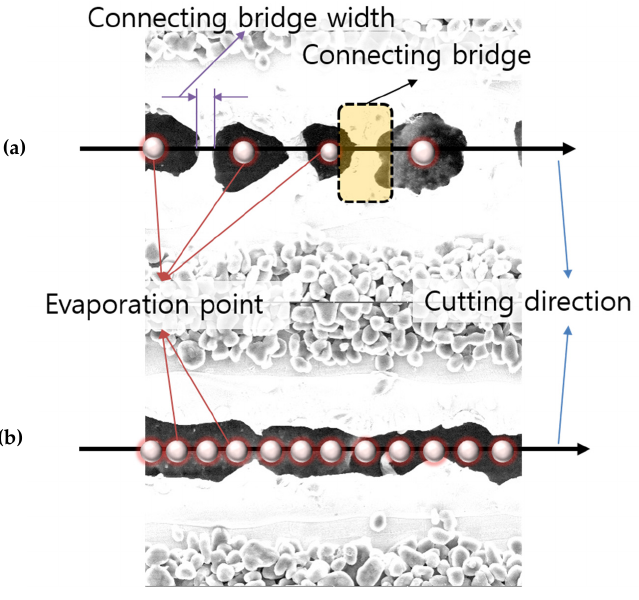
Figure 8. Evaporation points for ( a ) partial penetration and ( b ) full penetration.